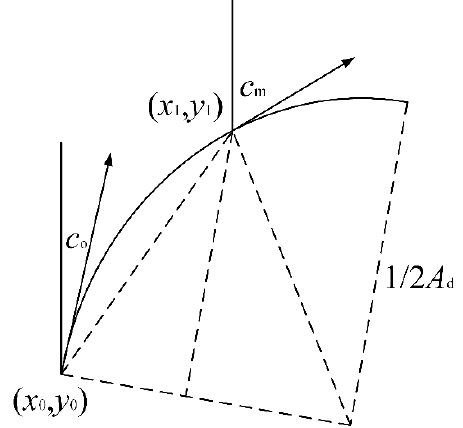
Figure 5. The illustration of Equations (3) and (4).